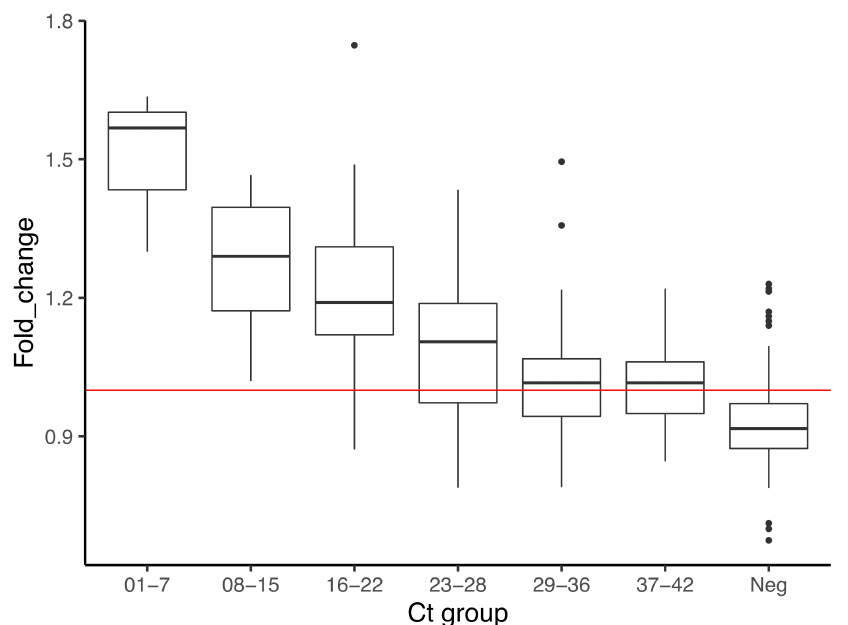
Figure 3. Relation between fold change and viral load. Y-axis indicates fold change values for a total of 208 samples, with the horizontal line corresponding to the threshold established. Boxes contain average and standard deviation of the fold change per Ct group, where Neg corresponds to the group with undetectable RNA of SARS-CoV-2 by qRT-PCR. The red line marks a fold change =